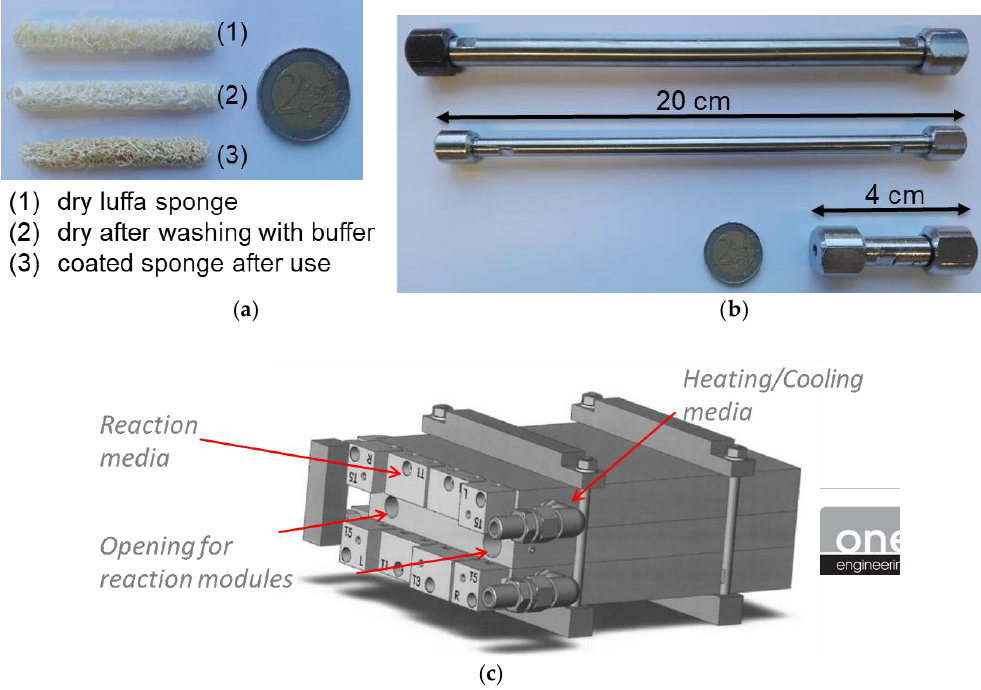
Figure 10. Equipment used for continuous synthesis: luffa sponge ( a ), stainless steel tube ( b ), and “Plug and Play” reactor ( c ).